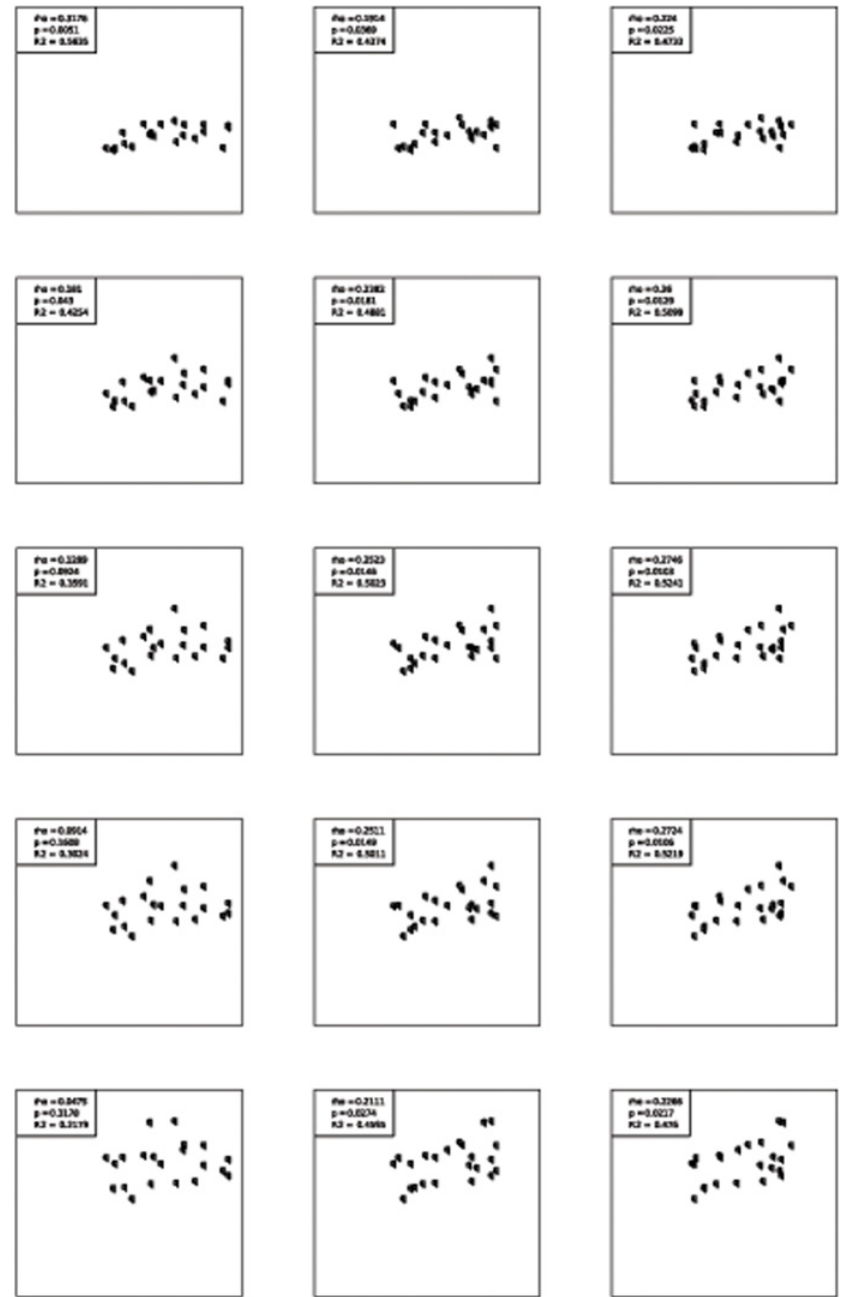
Fig 2. Association of 10mWT, 2MWT and 6MWT with different quantiles of real life walking speed. Walking speeds are based on sequences of at least 15 seconds uninterrupted walking, 6MWT = 6 Minute Walking Test, 2MWT = 2 Minute Walking Test, 10mWT = 10 meter Walking Test. Overall, 2MWT and 6MWT had a better and consistent correlation with all quantiles of real life walking speeds than the 10mWT but still explain only about a half of the variance of daily life walking speed. This moderate association confirms previous findings from Gijbels et al, who found similar correlations for habitual walking steps and 2/6MWT (R2: 0.42 and 0.46)